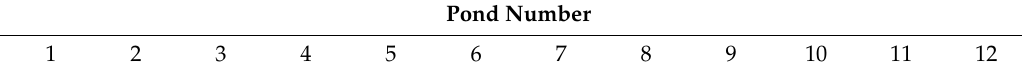
Table 4. ANOVA analysis: F = 64.938, p < 0.0001 ( p -values determined for depth of ponds). Pond Number